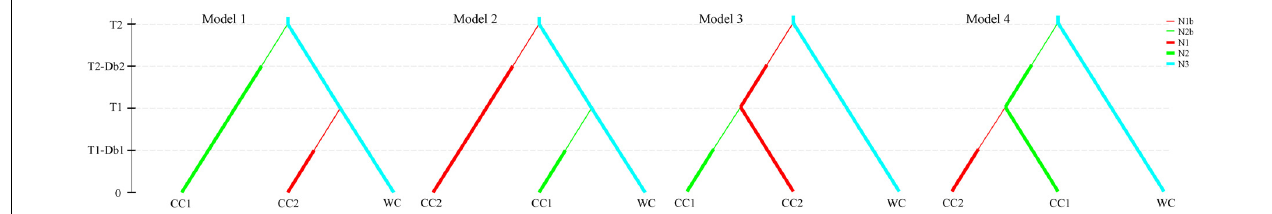
FIGURE 5 | Four Chinese cherry domestication models compared in approximate Bayesian computation (ABC) analysis. In model 1, we assume that CC 1 is first split from WC, and then CC 2 is separated from WC. We also set an independent domestication history for CC 1 and CC 2 , but assume that CC 2 is derived from WC first in model 2. For model 3, we assume that CC 2 is derived from WC first, and subsequently CC 1 is derived from CC 2 . In model 4, we assume that CC 1 is derived from WC first, and then CC 2 diverges from CC 1 . We design domestication bottlenecks for both CC 1 and CC 2 in each model. T1: the divergent time of the second